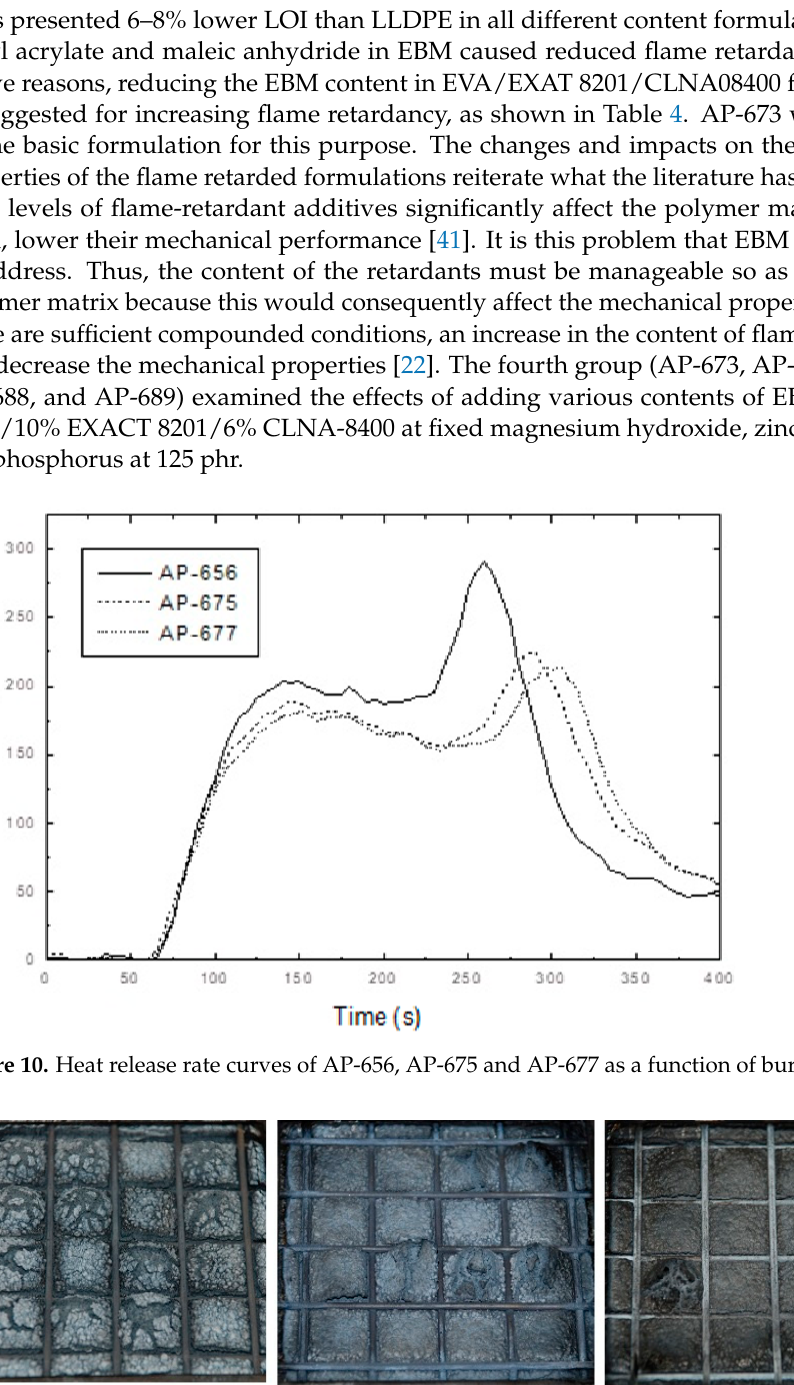
Figure 11. Photographs of the residua after cone calorimeter test of AP ‐ 656, AP ‐ 675 and AP ‐ 677.